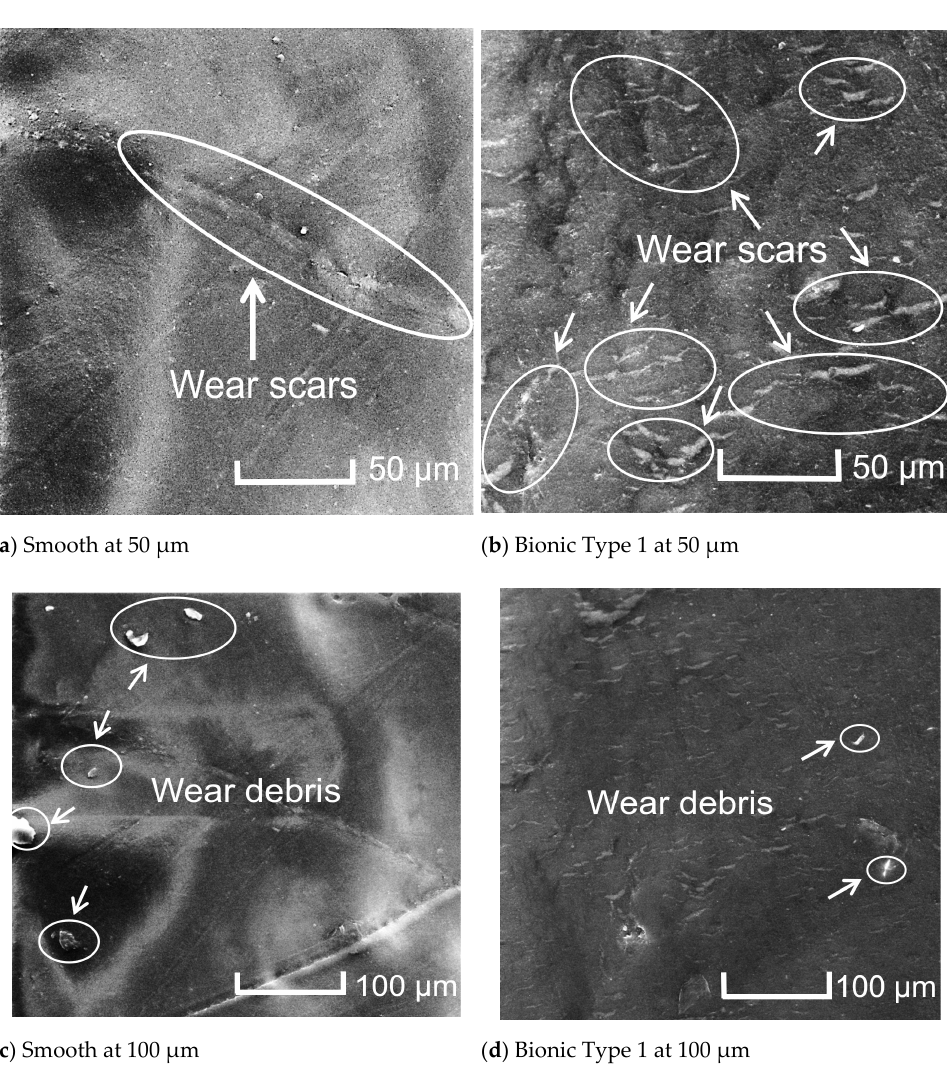
Figure 8. Worn micromorphology of different test samples.